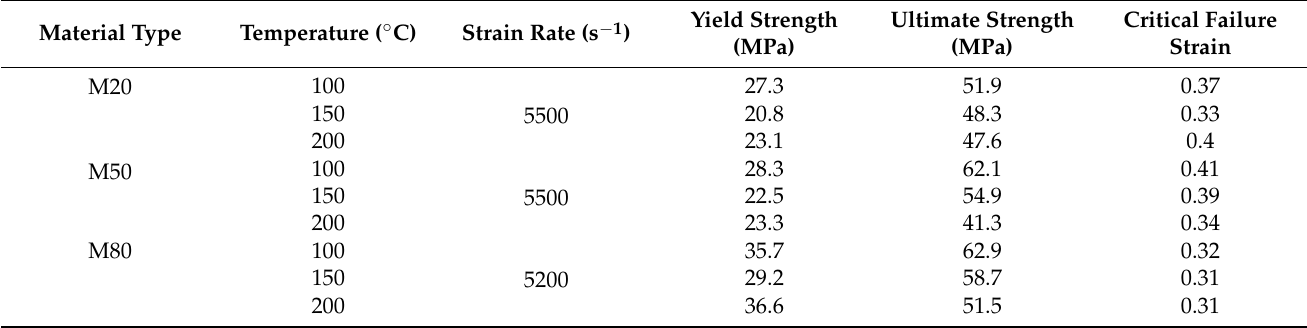
Table 4. Characteristic parameters of the Al-PTFE-W materials at elevated